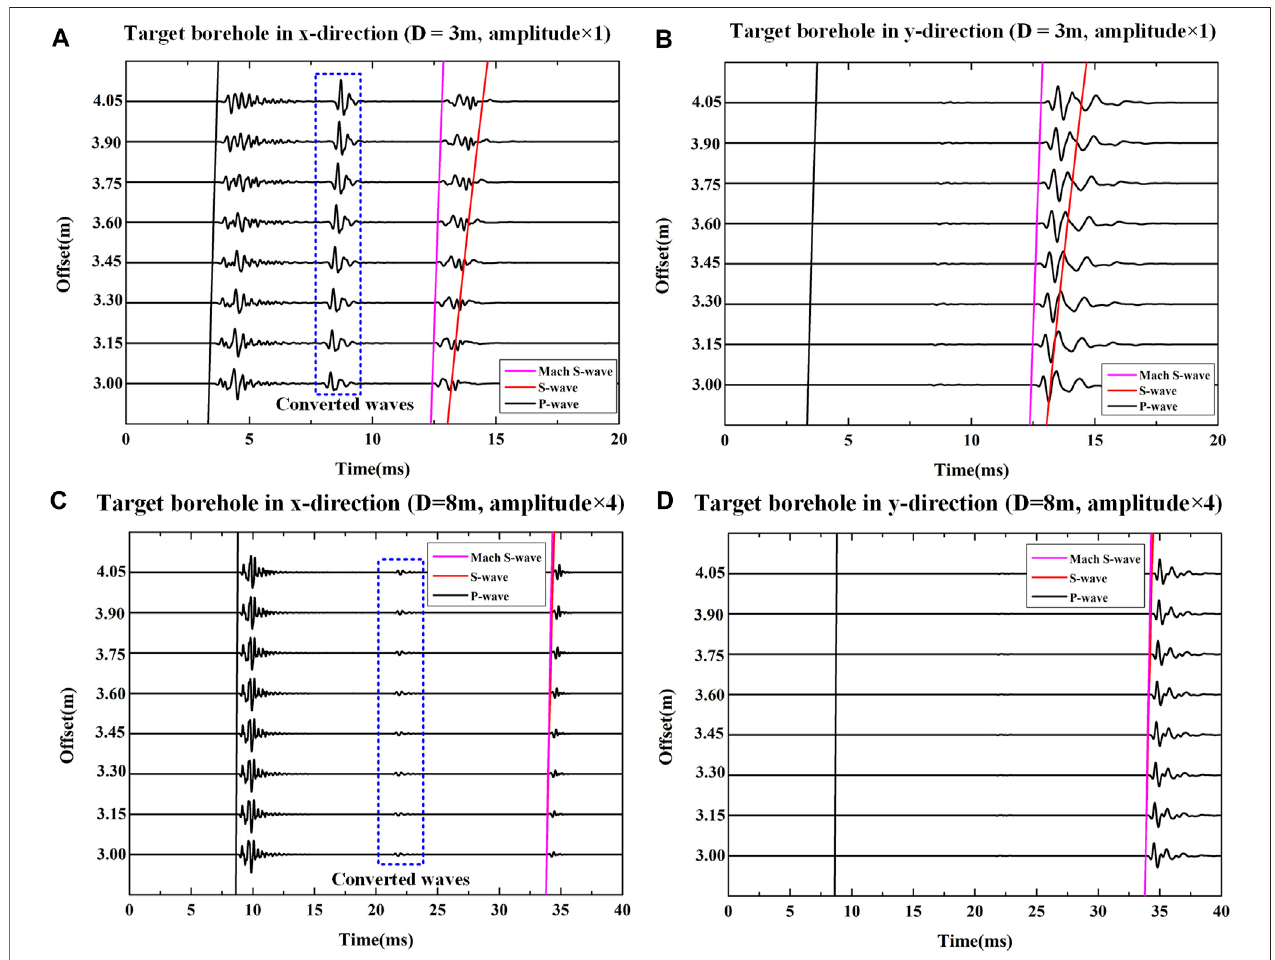
FIGURE11| Purescatteredwavesfromthenearbycasedboreholeatdifferentdistancesanddirections. (A) and (B) , (C) and (D) showtheresultswhen (D) isequal to 3 m and 8 m, respectively. The axis of target borehole is in the xoz -plane for (A) and (C) . The axis of target borehole is in the yoz -plane for (B) and (D) . The black, red and magenta lines represent the theoretical arrival times of the scattered P-wave, S-wave, Mach S-wave respectively.